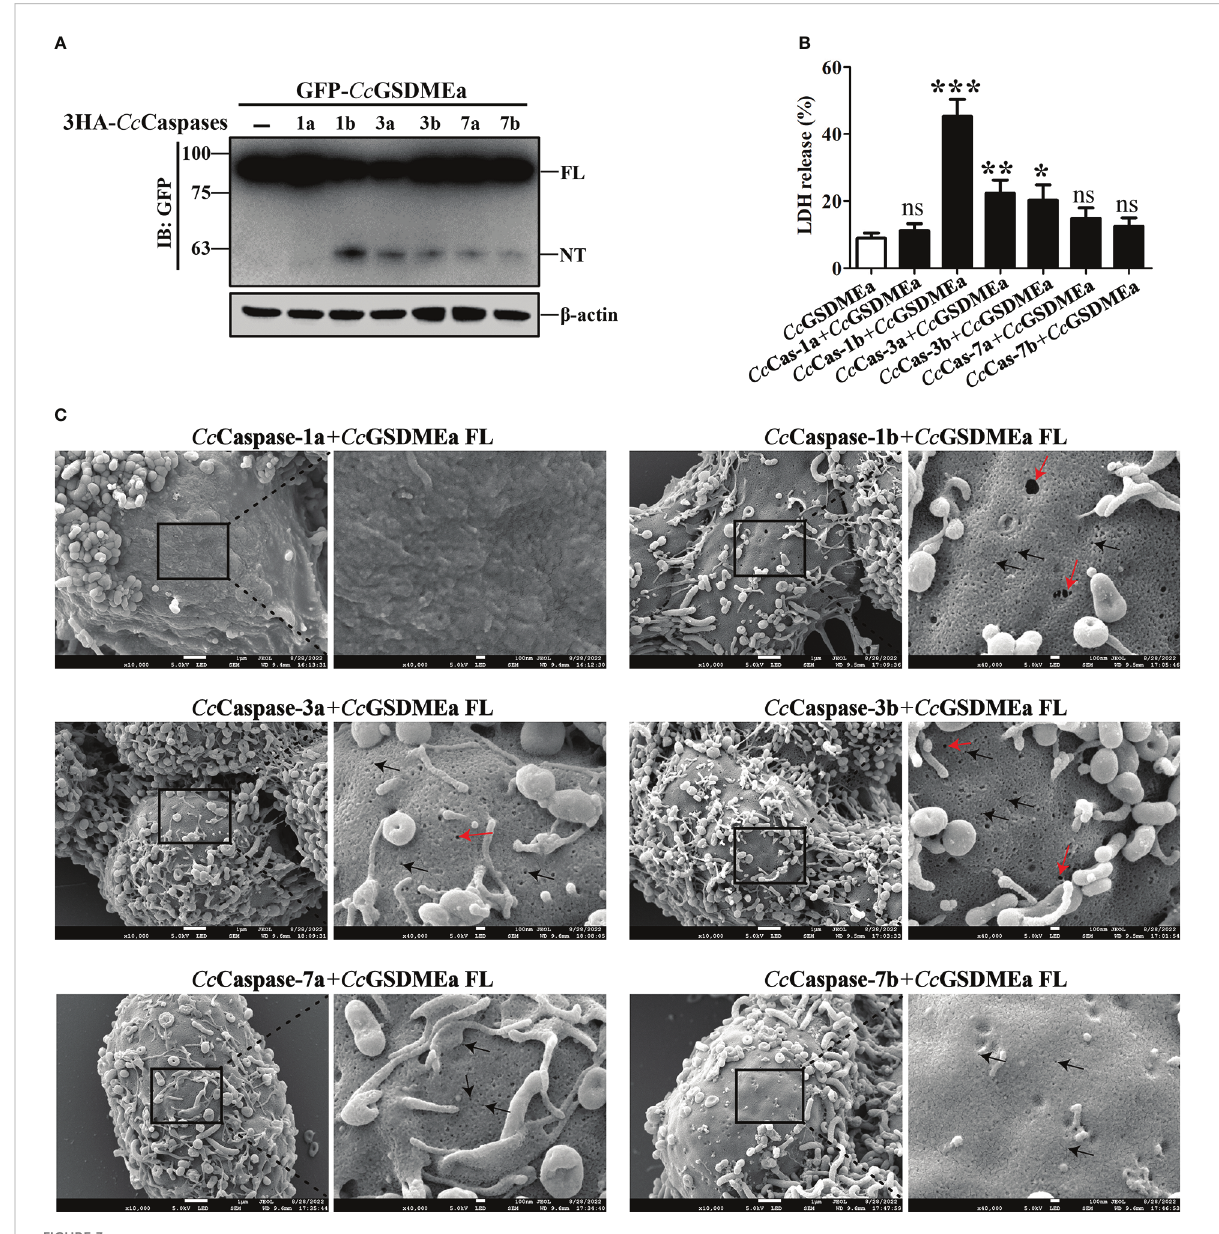
FIGURE 3 Cc GSDMEa-NT was produced from Cc GSDMEa cleavage by Cc Caspase-1/3/7. (A) The western bolting result that Cc GSDMEa was cleaved by Cc Caspase-1b/3a/3b/7a/7b. (B) LDH release from the EPC cells co-transfected with Cc GSDMEa and the Cc Caspase-1a/1b/3a/3b/7a/7b plasmids. (C) Morphological observation of HEK293T cells co-transfected with Cc GSDMEa and the Cc Caspase-1a/1b/3a/3b/7a/7b plasmids. Red arrows display cell plasma membrane rupture, and dark arrows indicate the gasdermin membrane pores. Values are shown as mean ± SD (n = 3). The LDH release from the cells only transfected with Cc GSDMEa was set as control. The signi fi cance difference of LDH release between the control cells and the co-transfected cells was analyzed by student ’ s t test and shown as: ns, P > 0.05; * , P < 0.05; ** , P < 0.01; *** , P <